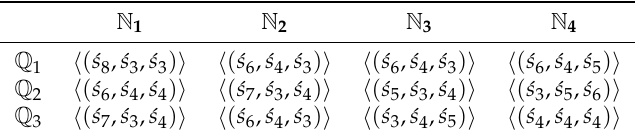
Table 5. The linguistic spherical fuzzy numbers decision matrix.